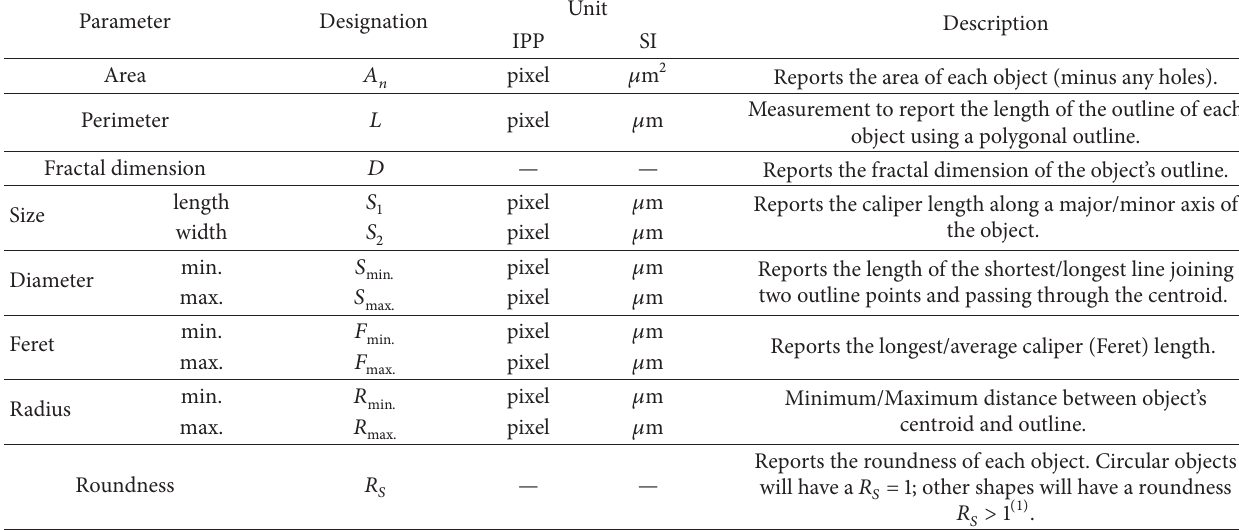
Table 5: Selected geometrical parameters available in Image Pro (cid:3) -Plus 5.1 software, used during morphological analysis of selected features characterizing spherical melted chips.